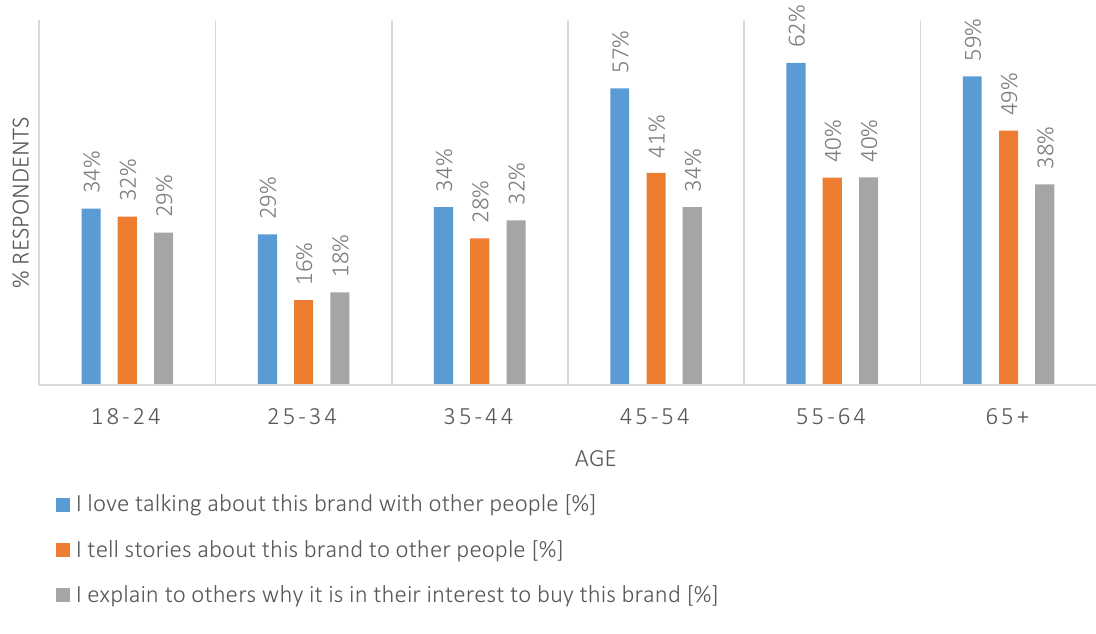
Figure 1. Consumer storytelling for generational nostalgic and non-nostalgic brands in specific age groups